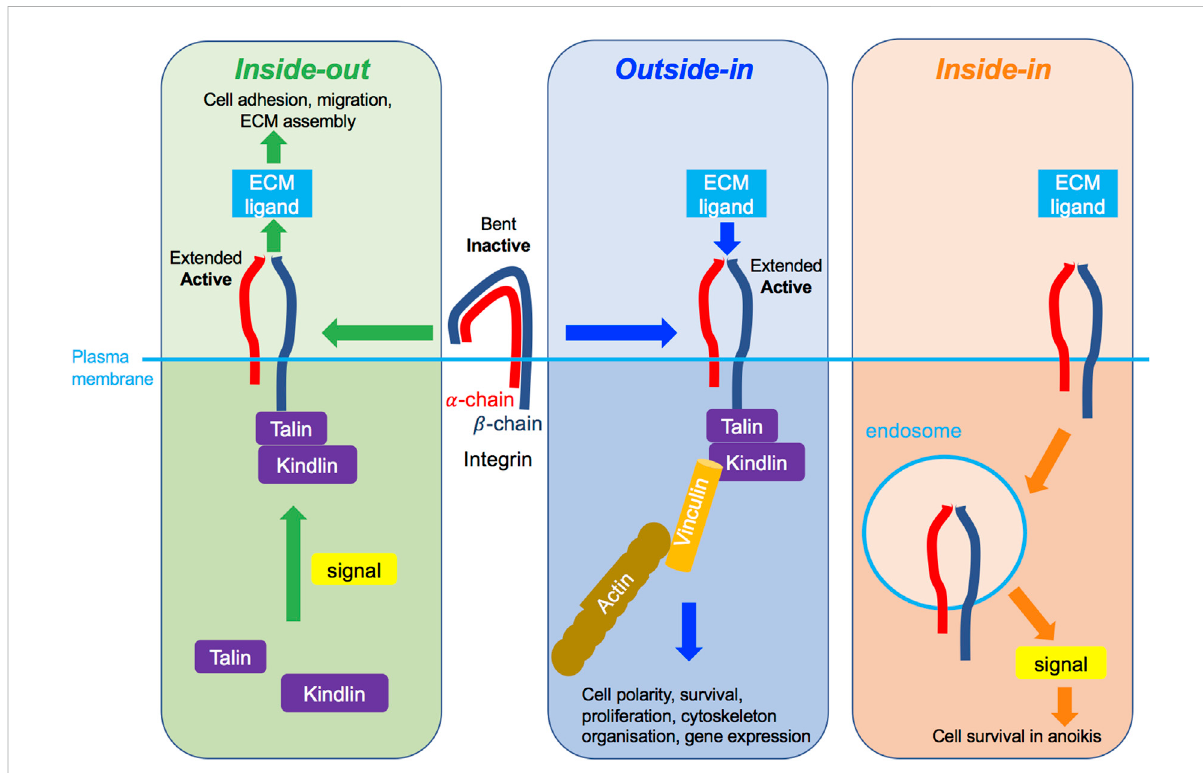
FIGURE 4 Different modes of integrin signalling. Left green box: Inside-out integrin signalling. An intracellular signal, such as promoted by an activated growth factor receptor, triggers the recruitment to the integrin β -chain of key molecules including talin and kindlin, leading to conformational change of integrins, which become extended and active and can then bind to its ligand in the ECM. As a consequence, cell adhesion, migration and/ or ECM assembly are promoted. Middle blue box: Outside-in integrin signalling. The binding of the integrin to the ECM outside of the cell triggers its change of conformation to become extended and active, leading to the recruitment of several moleculesto thecytoplasmictail of the β - chain, such as talin, kindlin and vinculin, and the connection to the actin cytoskeleton. As a consequence, cell polarity, survival, cytoskeleton organisation or gene expression are promoted. Right organge box: Inside-in signalling, a third mode of integrin signalling, recently described for β 1 integrin. The integrin transmits signalling from endosomes in cells in suspension alone. As a consequence, cell survival in anoikis is